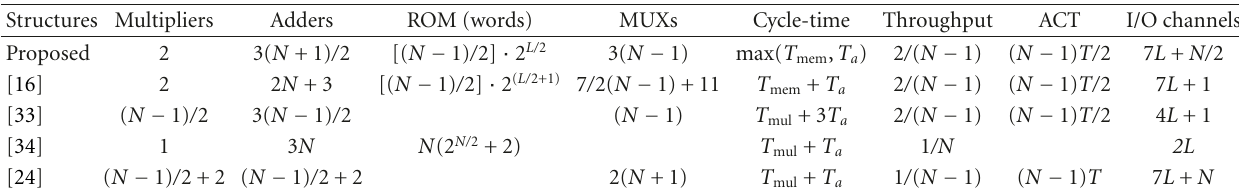
Table 1: Comparison of hardware complexity of various dct